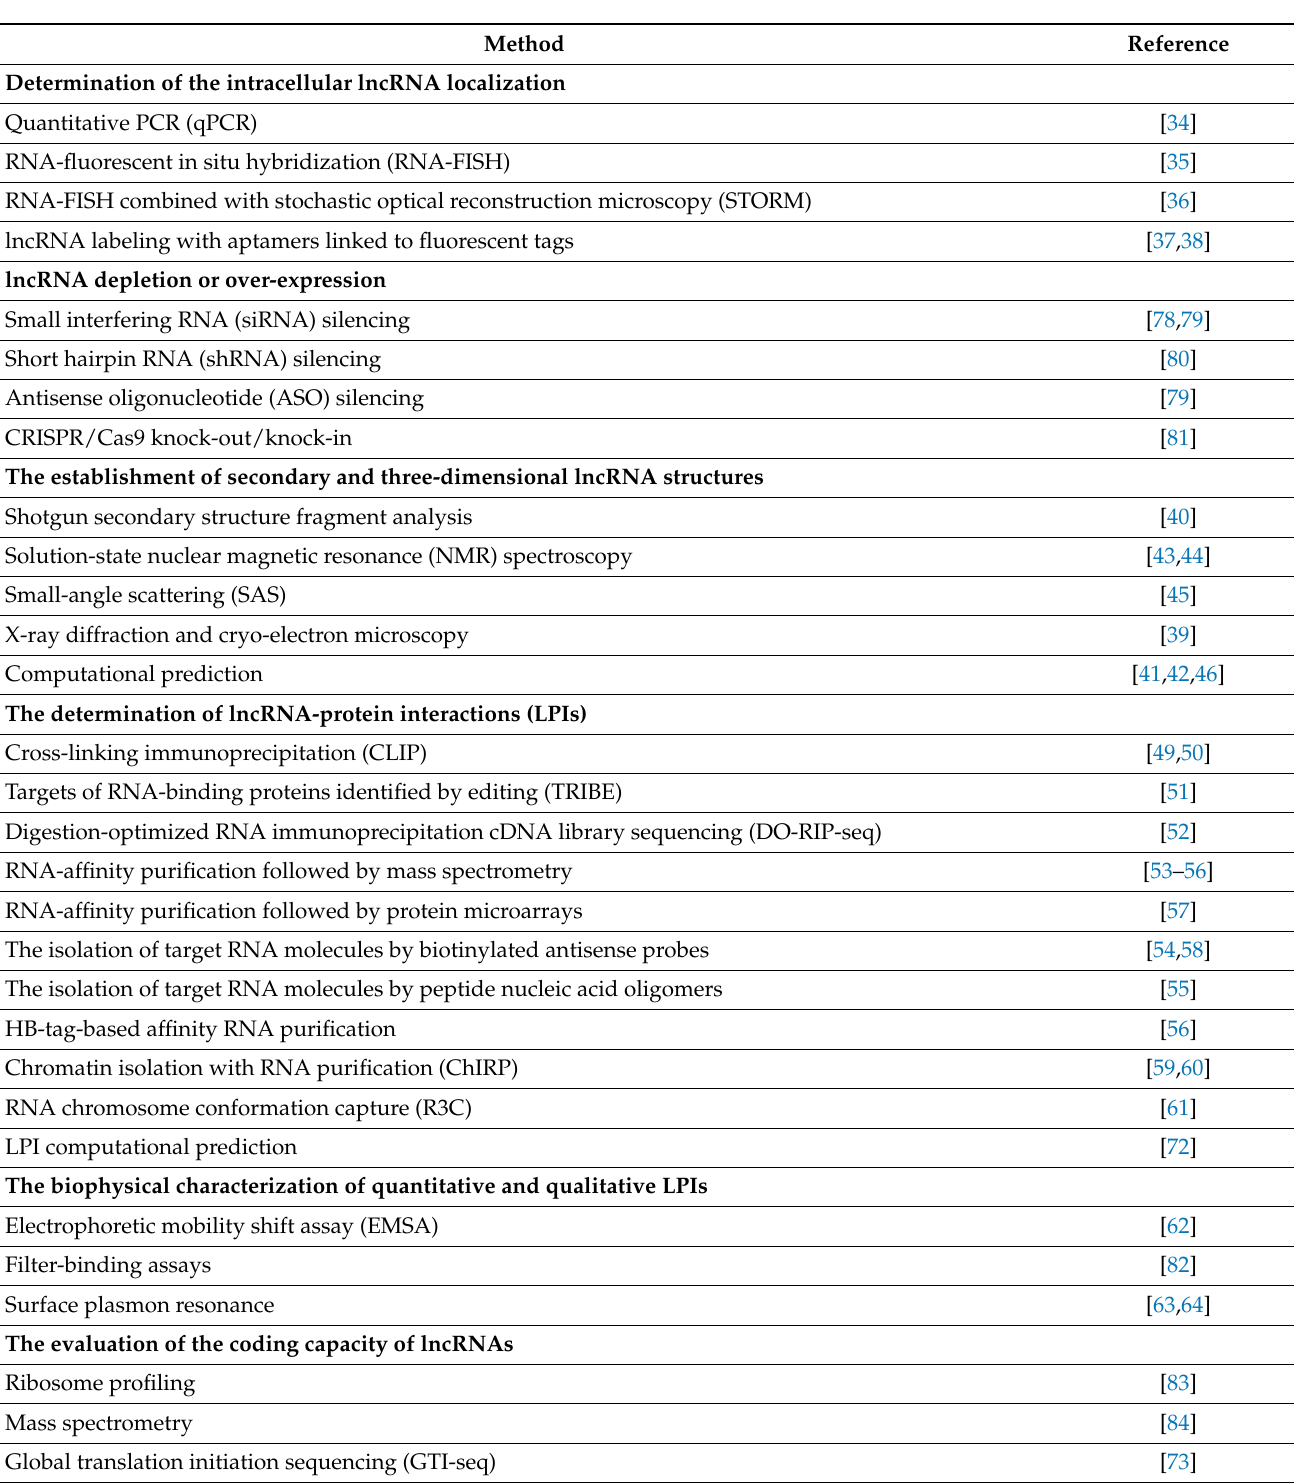
Table 1. Selected methods for functional lncRNA